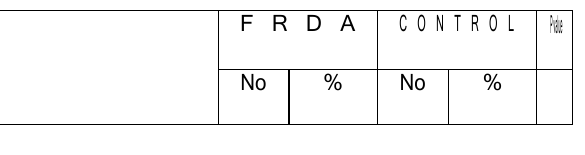
Table (3-4)The level of vitamin E for the (FRDA) and control according to age and gender.